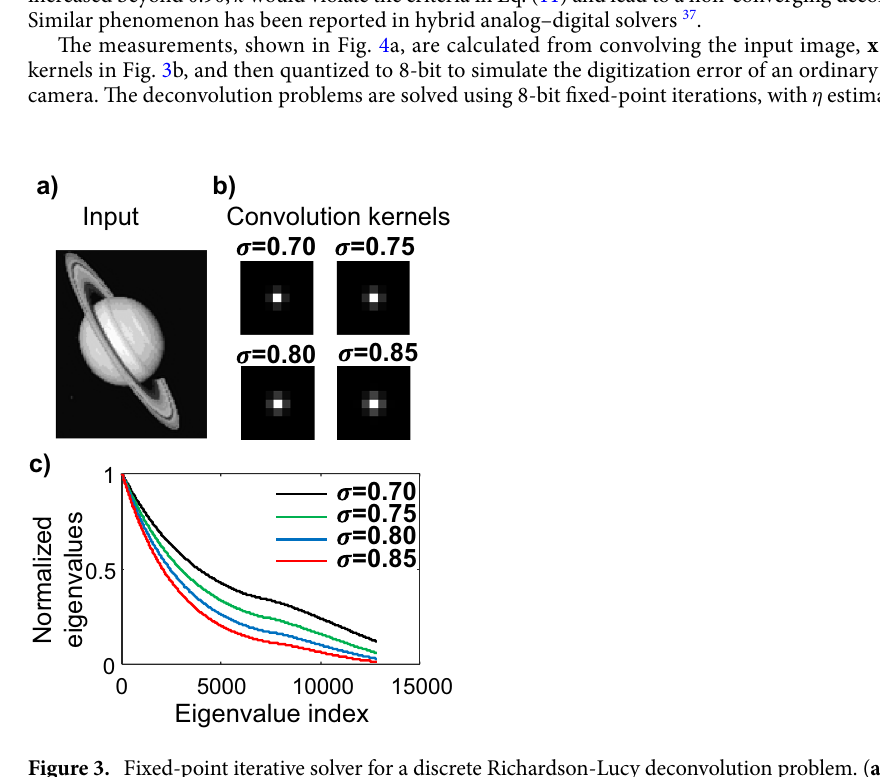
Figure 3. Fixed-point iterative solver for a discrete Richardson-Lucy deconvolution problem. ( a ) The 128 × 102 signed 4-bit input image “Saturn”. ( b ) Four convolution kernels with σ =0.70, 0.75, 0.80, and 0.85, respectively. ( c ) Eigenvalue spectra of the Toeplitz matrices calculated from the Fourier transforms of the convolution kernels. T A The condition numbers, κ , of A are 8.38, 16.59, 35.07, and 78.50,